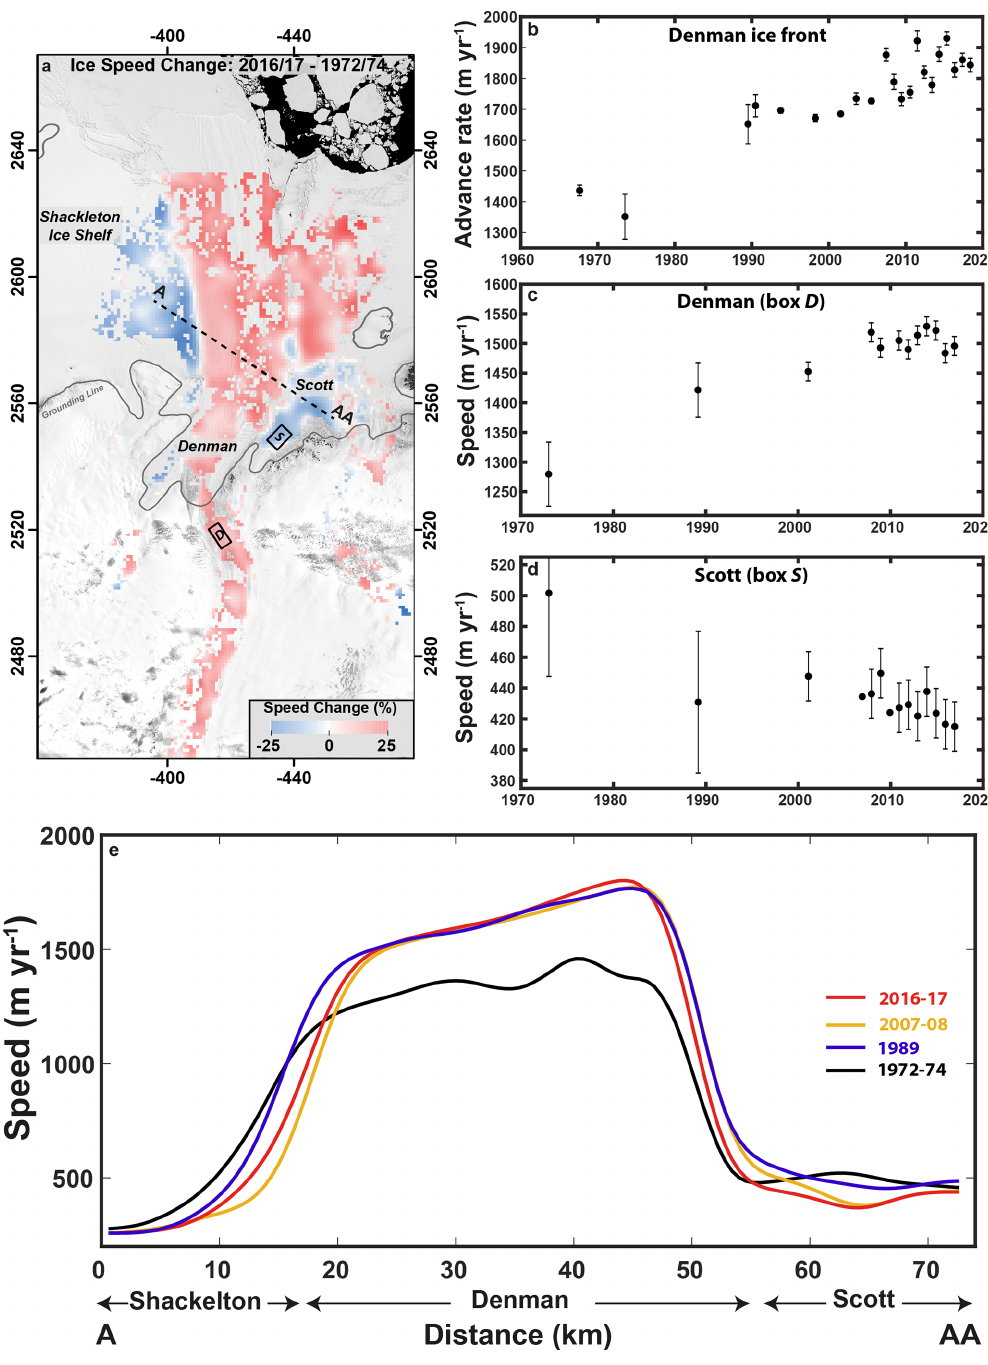
Figure 3. (a) Percentage difference in ice speed between 2016–2017 and 1972–1974 overlain on a Landsat-8 image from November 2017 provided by the U.S. Geological Survey. Red indicates a relative increase in 2016–2017 and blue a relative decrease in 2016–2017. The grounding line is in grey (Depoorter et al., 2013). (b) Time series of the advance rate of the Denman ice front 1962–2018. (c) Time series of mean ice speed from box D , 1972–2017, approximately 10km behind the Denman grounding line. (d) Time series of mean ice speed from box S on Scott Glacier, 1972–2017. (e) Ice speed profiles across the Shackleton–Denman–Scott system from 1972–1974, 1989, 2007–2008 and 2016–2017. Note the lateral migration of the shear